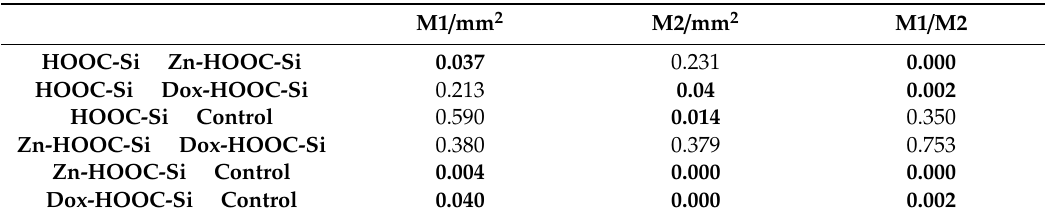
Table 8. Statistical results ( p values) after pairwise comparisons. Bold numbers mean significance at p <